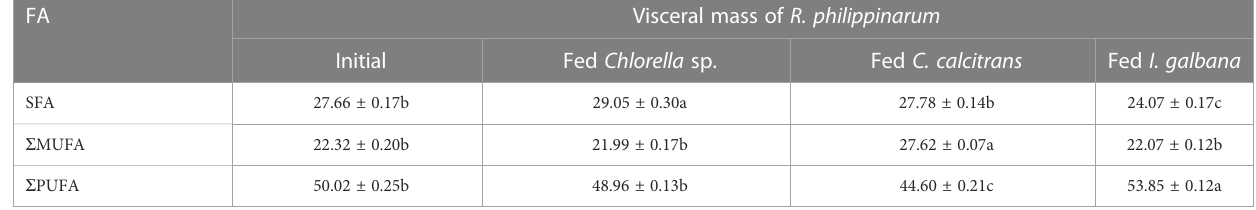
signi fi cantly lower than those fed with C. calcitrans and I. galbana (Table 1). In addition, the amount of 18:3n-6 and 18:4n-3 was decreased in R. philippinarum fed with Chlorella sp. and C. calcitrans , which was signi fi cantly lower than that in those fed